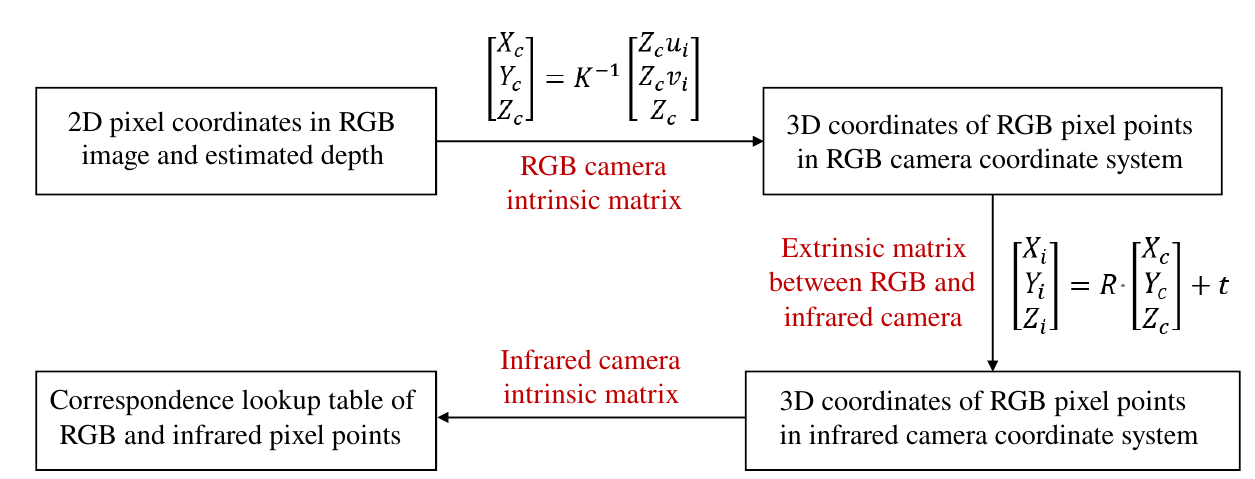
Figure 7. Procedure of data registration between the RGB image and FIR image.